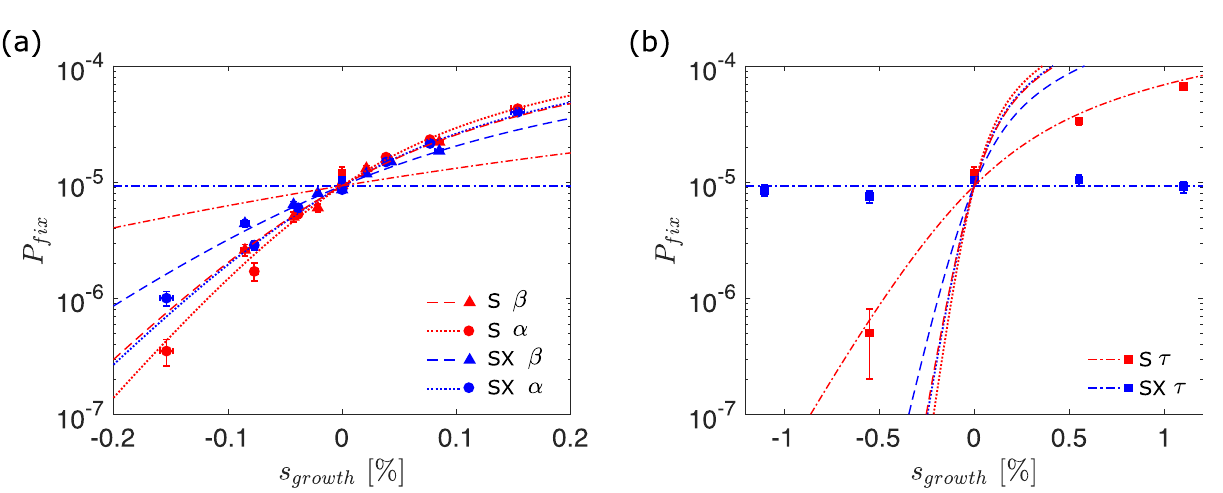
Fig 5. Fixation of non-neutral mutants. Probability of mutant fixation P as a function of selective growth advantage s fix simulation results, while lines indicate theoretically predicted values in a Moran model with equivalent parameters (Eq 1). Data points for the α and β mutants have been omitted from the right hand panel for clarity. The error in our estimate of the fixation probability Δ P where n and n represent the total number of simulations and the number of simulations where the mutant fixes respectively. Error bars in the x -axis fix represent the errors on the growth rate fitness s that each burst size corresponds to. These are calculated by fitting a linear relation to growth rate growth measurements such that s growth = m ( β mut − β res ). The fractional error on the s growth is then equal to the fractional error on the fitted gradient m . The data is obtained from a minimum of 5 million independent simulations.